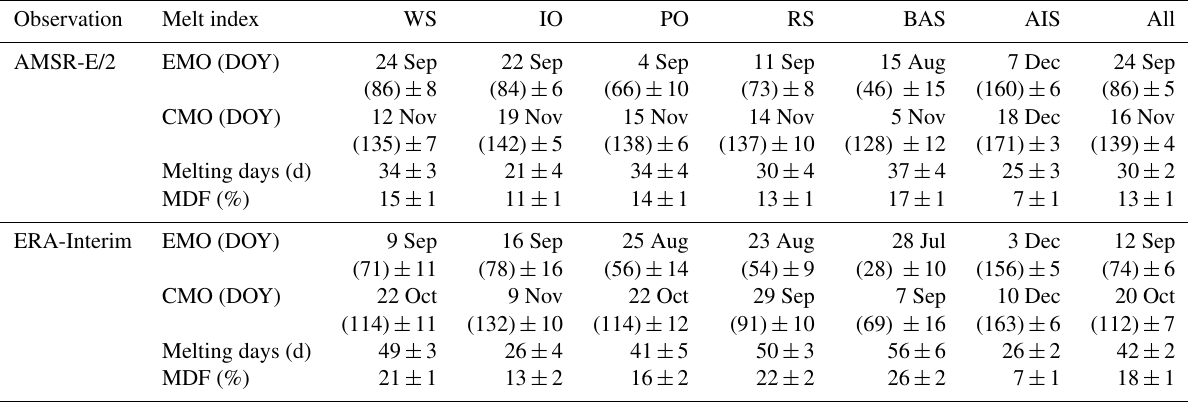
Table 1. Annual mean and standard deviation of pan-Antarctic region EMO, CMO, melting days and MDF derived by AMSR-E/2 and